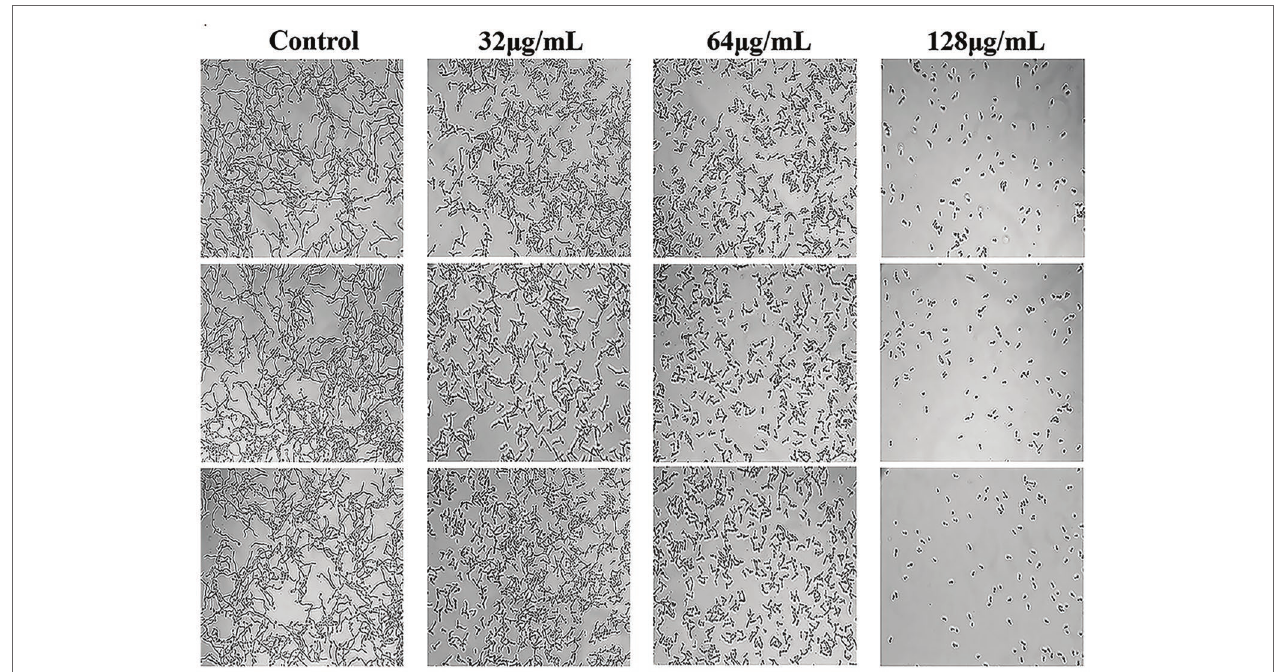
FIGURE 5 | Effect of NBP on C. albicans hyphal growth induced by spider medium. NBP was diluted in hyphae-inducing media, spider medium, at a final concentration of 0, 32, 64, and 128 μg/ml, respectively. The cellular morphology was photographed after incubation at 37 ° C for 4 h. The photographs were collected from three independent experiments.